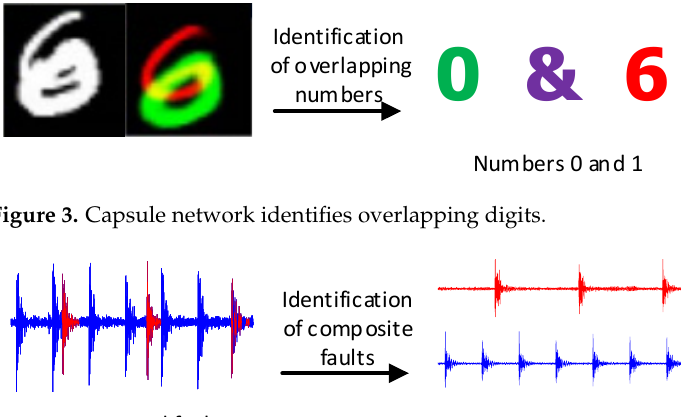
Figure 4. Identify faults A and B .